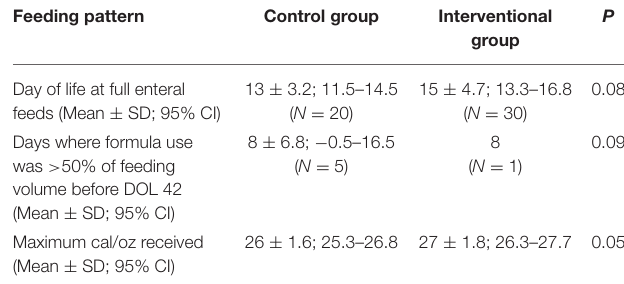
TABLE 4B | Characteristics of infants who returned for neurodevelopmental follow-up.